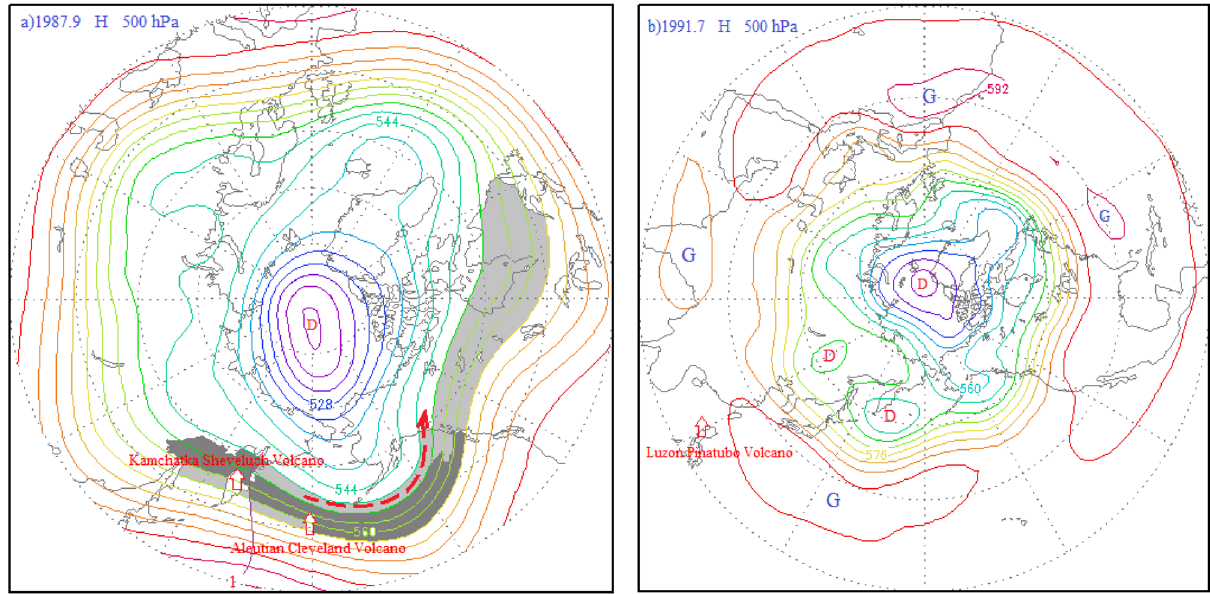
Figure 5. ( a ) 500 hPa atmospheric circulation characteristics and distribution diagram of the volcanic dust curtain and aerosol layer in the mid-high latitudes (40–90° N) in September 1987; ( b ) schematic diagram of the atmospheric circulation characteristics of the 500 hPa layer from 10 to 90° N in July